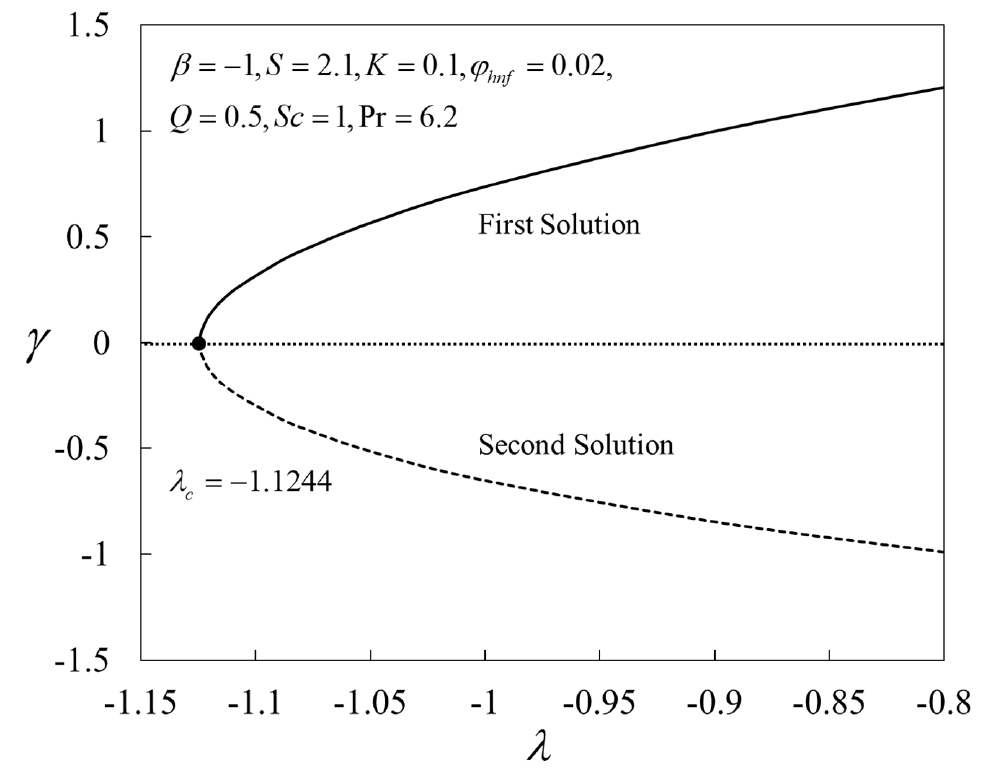
Figure 12. Plot of  against  . Figure 12. Plot of γ against λ